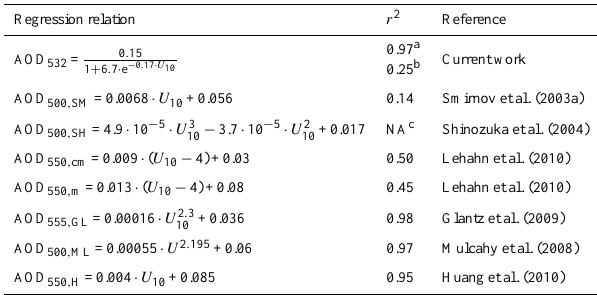
Table 1. Regression statistics of aerosol optical depth versus wind speed.